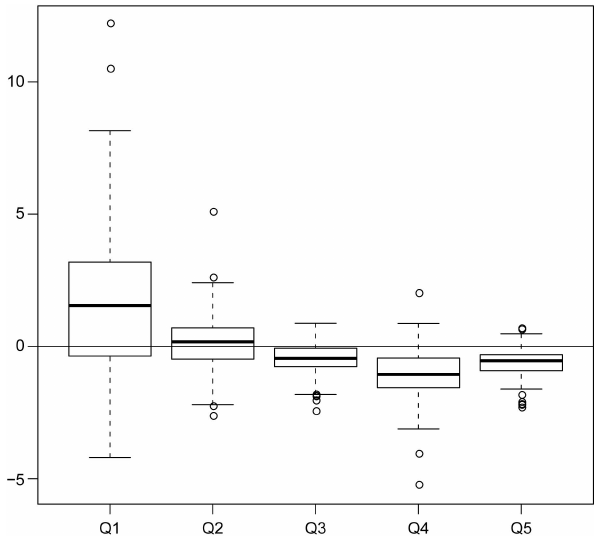
Fig. 5. Boxplots of trends with the number of daily rainfall erosivity events classified by quintiles of daily erosivity over the whole period 1955–2006. Table 2. Number and proportion of series with trends in the number of events in the first quintile (Q1), significance level α = 0 . 05.